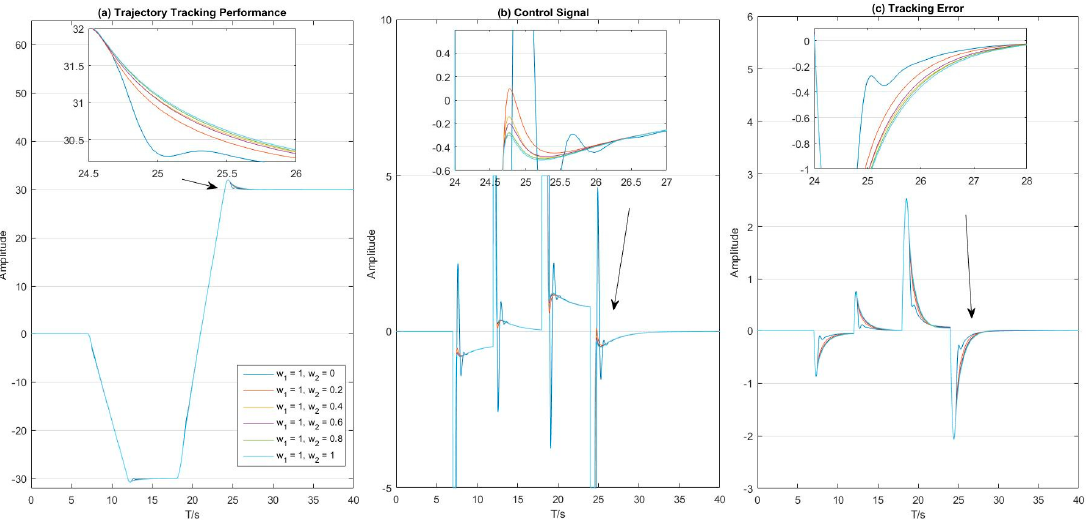
Figure 5. Trajectory tracking performance of AUV yaw system.